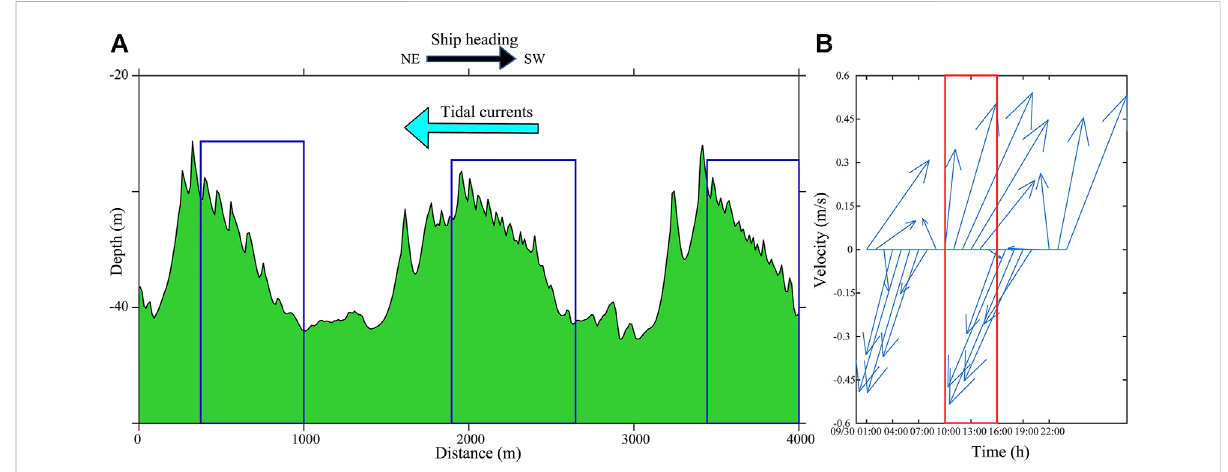
FIGURE 7 (A) Apartofthemultibeambathymetricpro fi leofLine46depicting themuchsmallersecondarysandwavesridingonthesideofprimarydunes. Both the ship heading and the direction of tidal current are also shown. (B) A time-series vector plot of the tidal fl ow generated using the TPXO data (https://tpxows.azurewebsites.net) for the position shown in Figure 1 (117.7757 ° E, 23.2510 ° N). The multibeam survey was collected in the time window (between the two red vertical lines) during which tidal currents fl owed toward upcoast (toward